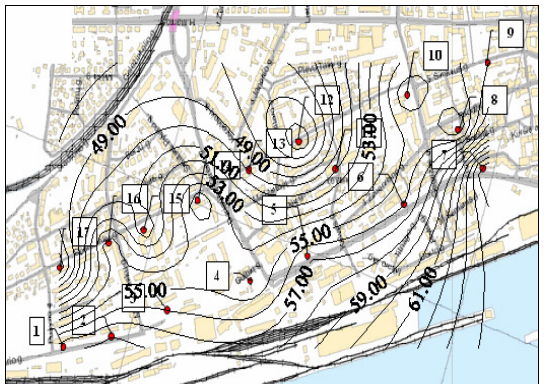
Fig. 10. Noise spread in the northern part of Klaipėda city at night in